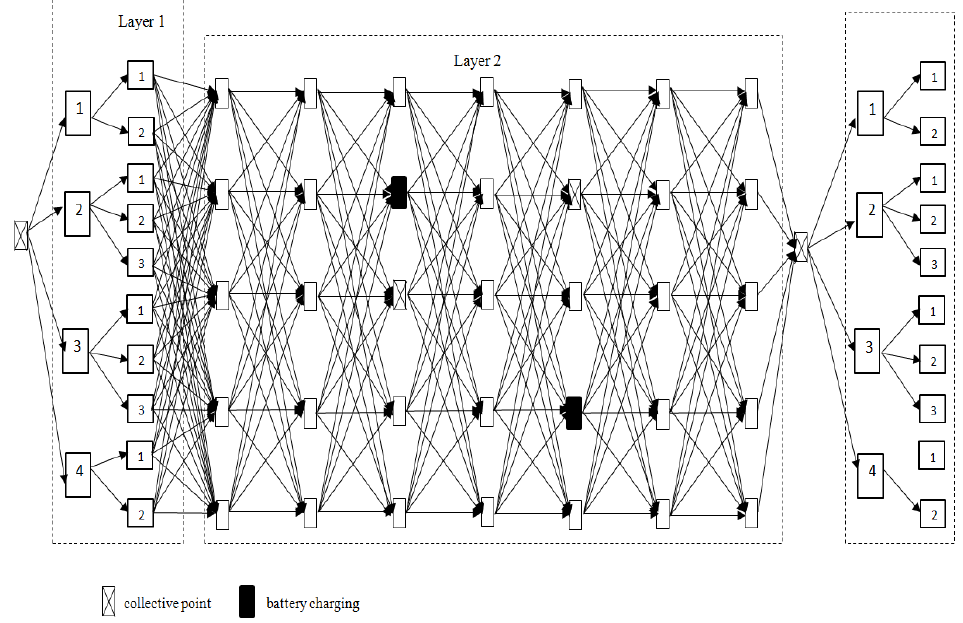
Figure 1. Elements of the ant’s